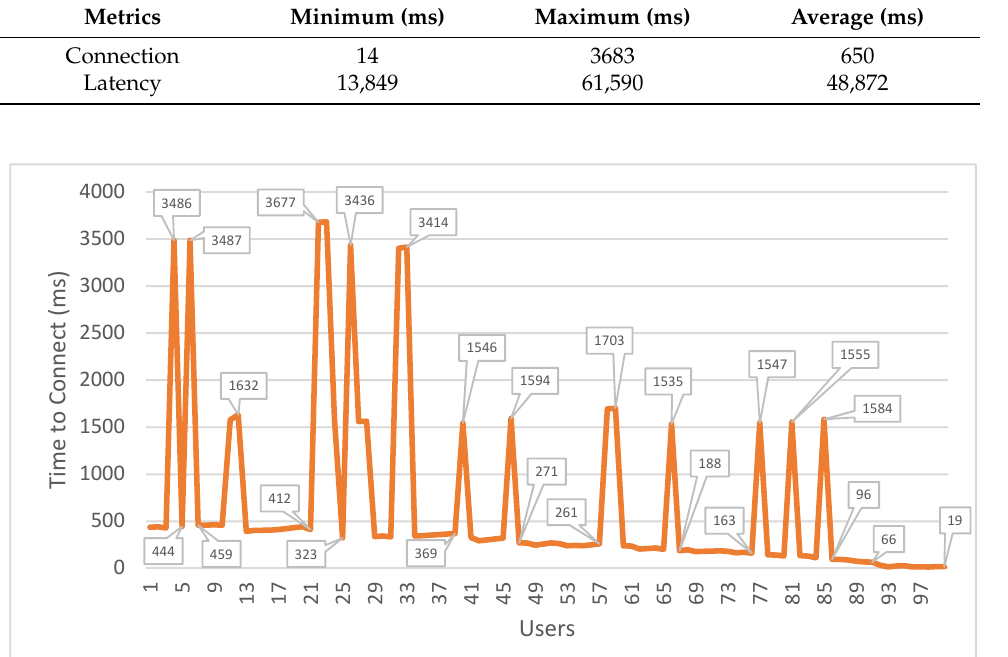
Table 1. Connection and latency metrics.